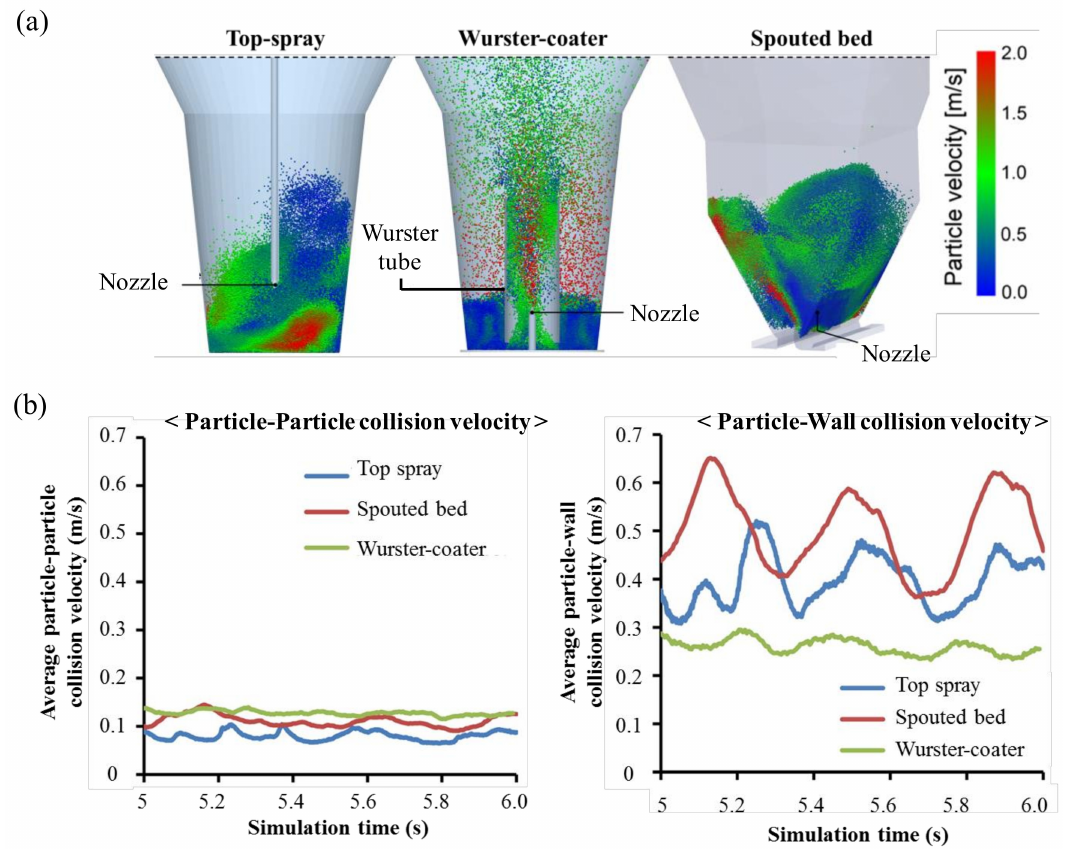
Figure 8. Comparison of three fluidized bed granulators (Top-spray, Wurster-coater and Spouted bed): ( a ) simulation snapshots under the same process conditions, particle flow and particle velocity fields were captured; ( b ) profiles of the particle-particle and particle-wall collision velocities within the stable fluidization regime (during a simulation time of 5–6 s) [134]. The figures were slightly modified, with permission from